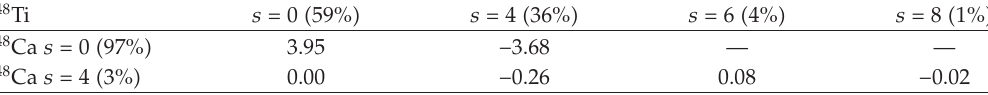
Table 2: The GT NMEs of the A (cid:7) 48 decay in the generalized seniority